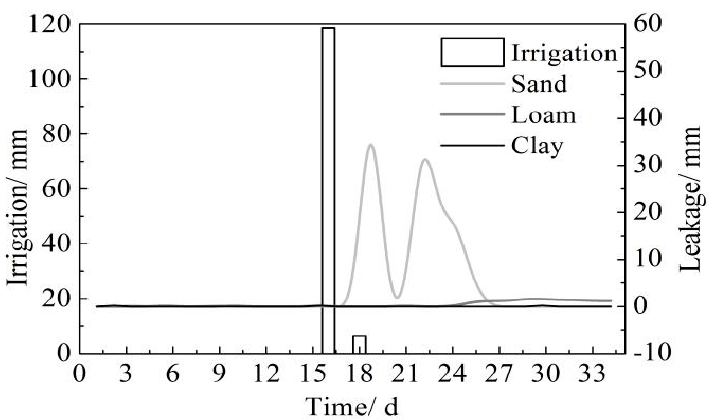
Figure 5. Daily variation of deep soil water leakage below 150 cm of different soil textures.